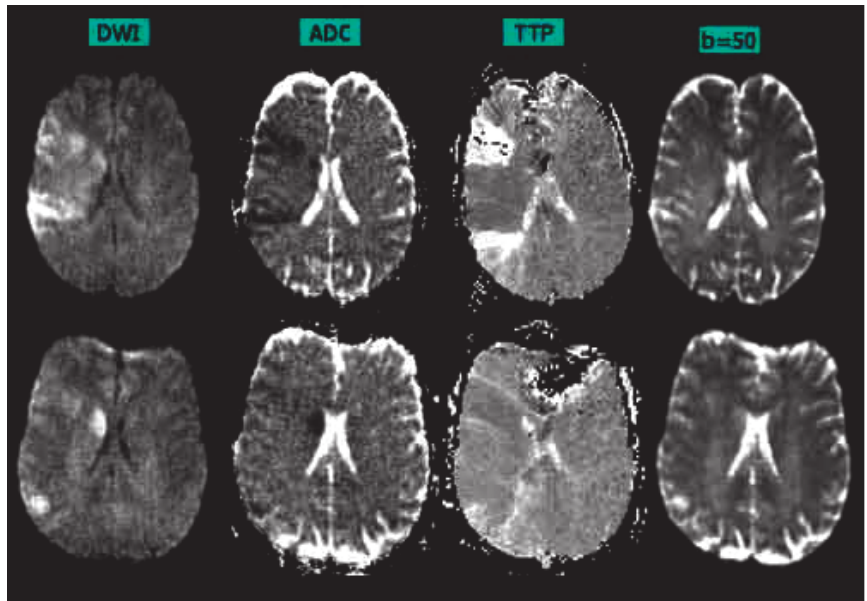
Reversible lesion after intra-arterial thrombolysis. MRI performed acutely shows (upper row) the presence of a hy- perintensity on DWI (left image) corre- sponding to a de- crease in ADC and changes in the time to peak values. After successful intra-arte- rial thrombolysis (lower row) the DWI changes tend to di- minish whereas the perfusion deficit is